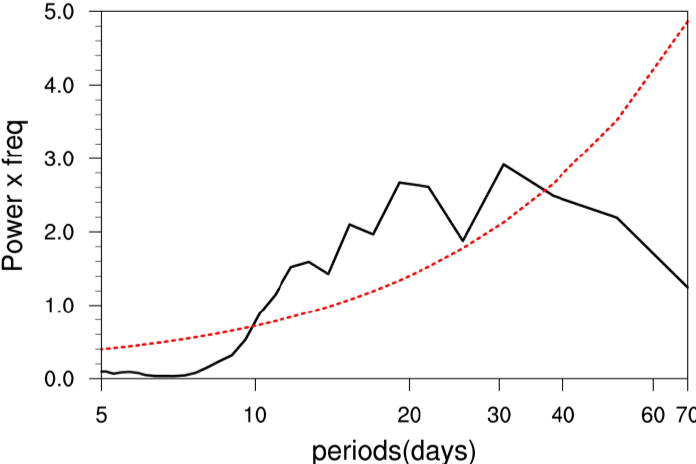
Figure 2. Extended Summer mean power spectra of daily Tmax over the Jiangnan region (black line) during 1981 – 2018, red line represents the 95% significant level of red noise spectrum.